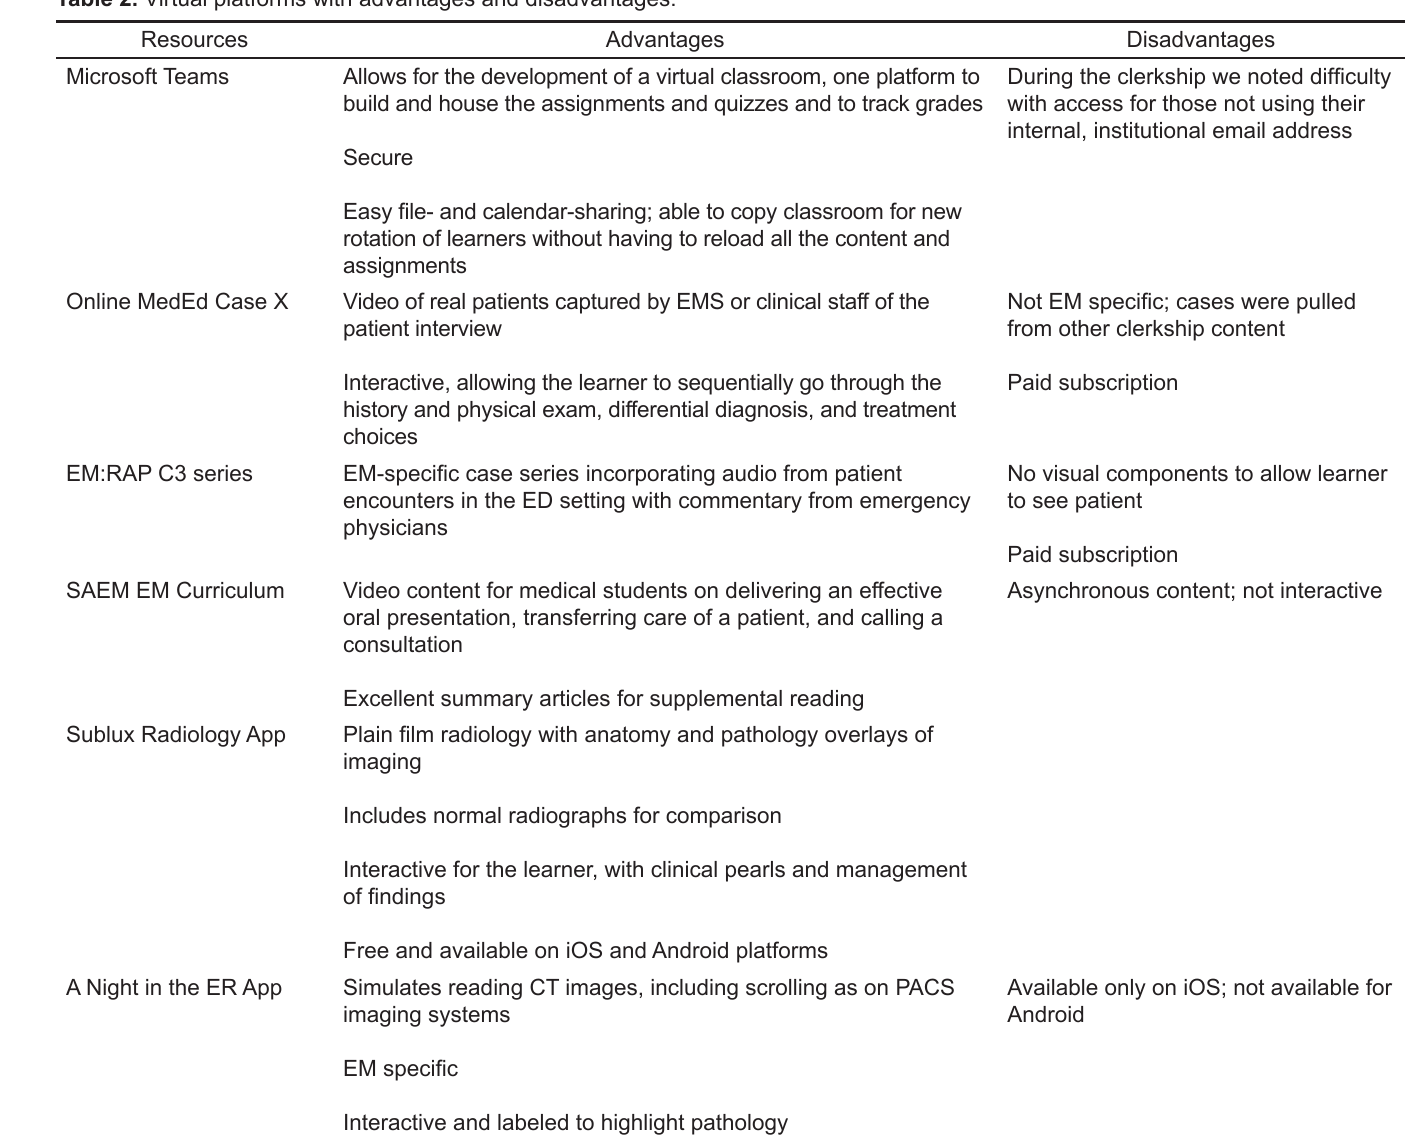
Table 2. Virtual platforms with advantages and disadvantages.*